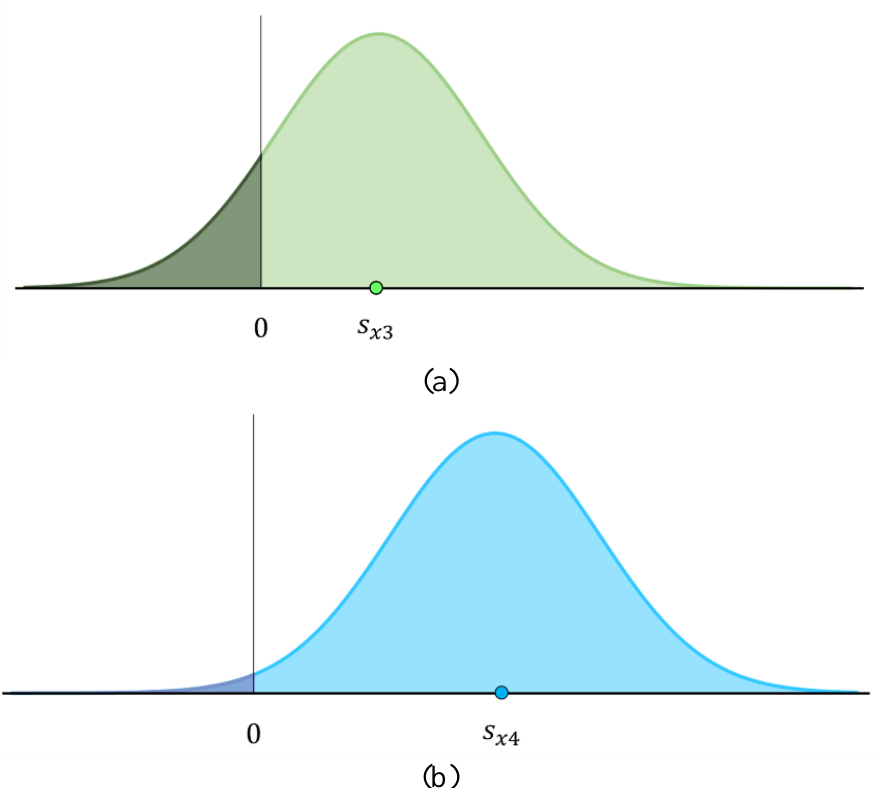
Figure 5. The conditional PDF ( a ) Pr ( y k | s x 3 ) . ( b ) Pr ( y k | s x 4 ) . The dark region represents the probabil- ity of